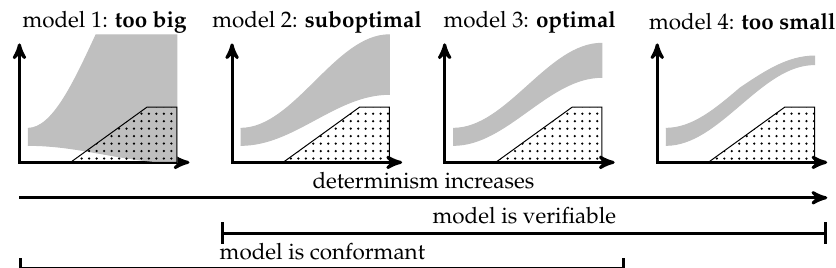
Figure 1. The reachable states (gray area) of several verification models as well as the unsafe states (dotted area) are shown. For increasing determinism, the set of reachable states is becoming smaller. When the reachable set is too small to contain all possible states of the real system, it is no longer conformant. Also, when the reachable is too big, it intersects with the unsafe state, and thus, it cannot be used for successful verification. The optimal model has the most determinism while being